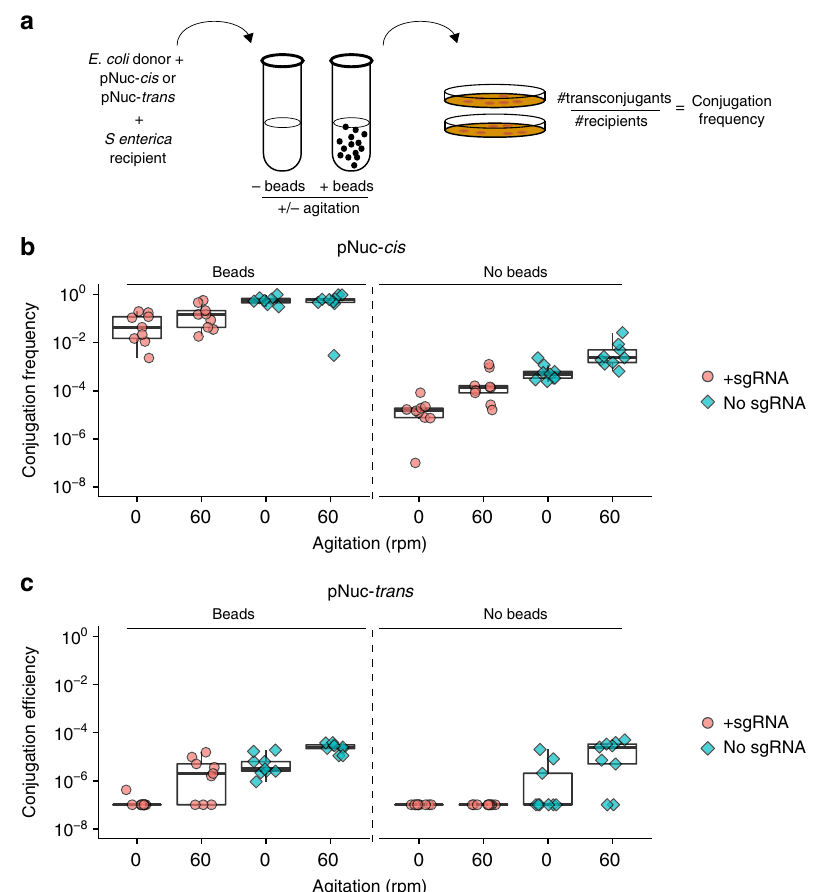
Fig. 2 In fl uence of enhanced cell-to-cell contact on conjugation frequency. a Schematic of experimental design. Liquid conjugation experiments in culture tubes with b pNuc- cis and c pNuc- trans were performed with 0.5 mm glass beads or without glass beads ( fi lled diamonds) over 72 h at the indicated shaking speed (in revolutions per minute). Conjugations were performed with ( fi lled circles) or without ( fi lled diamonds) sgRNA targeting the STM1005 locus cloned into pNuc- cis and pNuc- trans . Both plasmids encoded the TevSpCas9 nuclease. Data are plotted on a log10 as boxplots with data points from independent biological replicates. The solid line represents the median of data, the rectangle represents the interquartile range of the data, and the whiskers represent the maximum and minimum of the data. Source data are provided as a Source Data fi